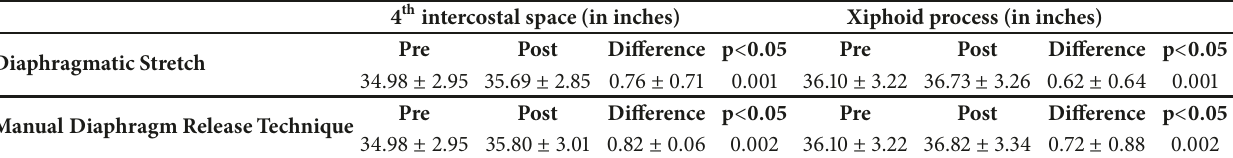
Table 4: Comparison of Chest Expansion before and after Diaphragmatic Stretch Technique and Manual Diaphragm Release Technique. 4 th intercostal space (in inches) Diaphragmatic Stretch